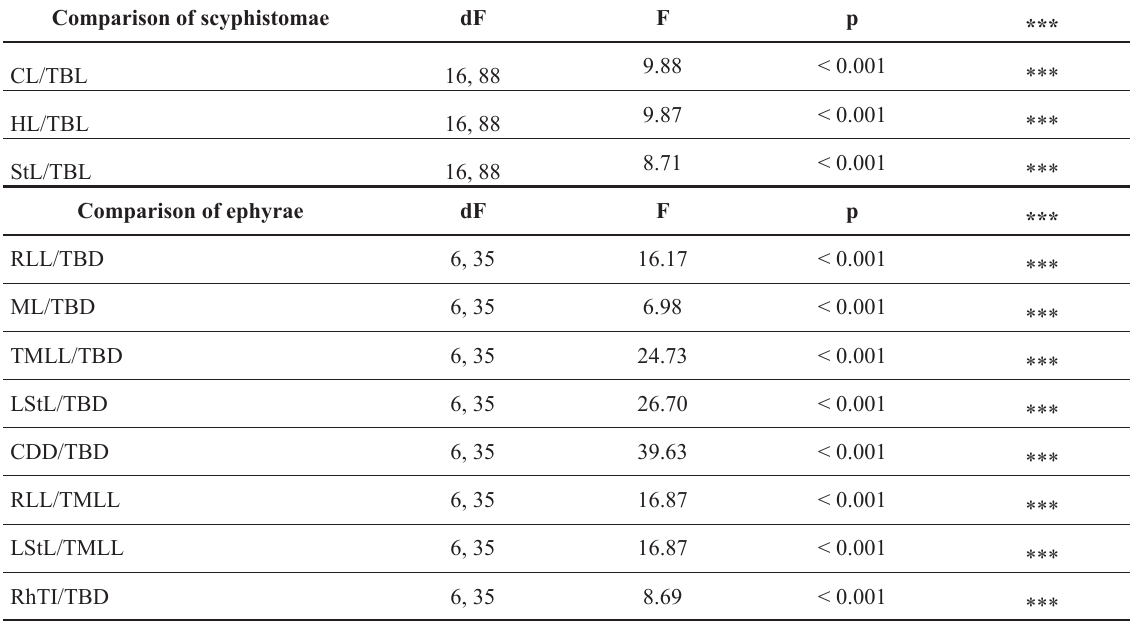
Table 4. Analysis of Variances (ANOVA) for morphometric indices of scyphistomae and ephyrae. Abbreviations: df = degrees of freedom; F = F-Ratio; p = p-Value. Other abbreviations: see Table 2 Comparison of